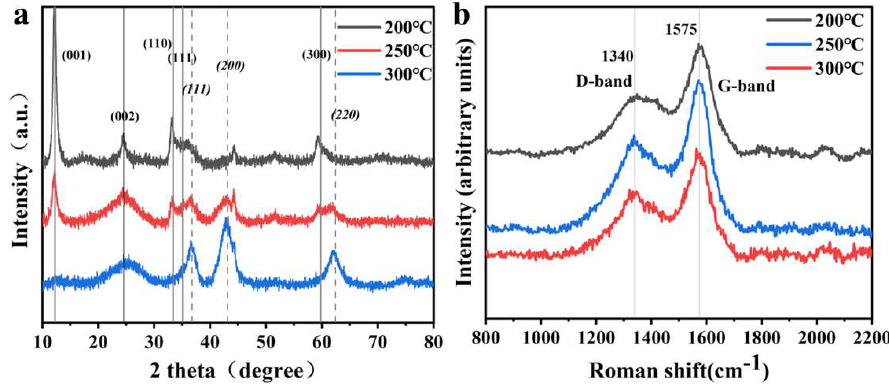
Figure 2. XRD spectra ( a ) and Raman patterns ( b ) of CNFs@Ni(OH) 2 /NiO-X. The Raman spectra of CNFs@Ni(OH) 2 /NiO-X (Figure 2b) displayed that their curves contained two distinctive characteristic peaks located at about 1340 cm −1 and about 1575 cm −1 , respectively, corresponding to the D-band and G-band of the C-atom crystal. The